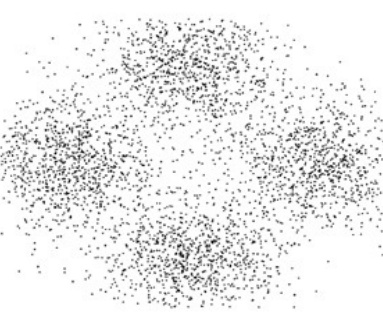
Appl. Sci. 2020 , 10 , x FOR PEER REVIEW